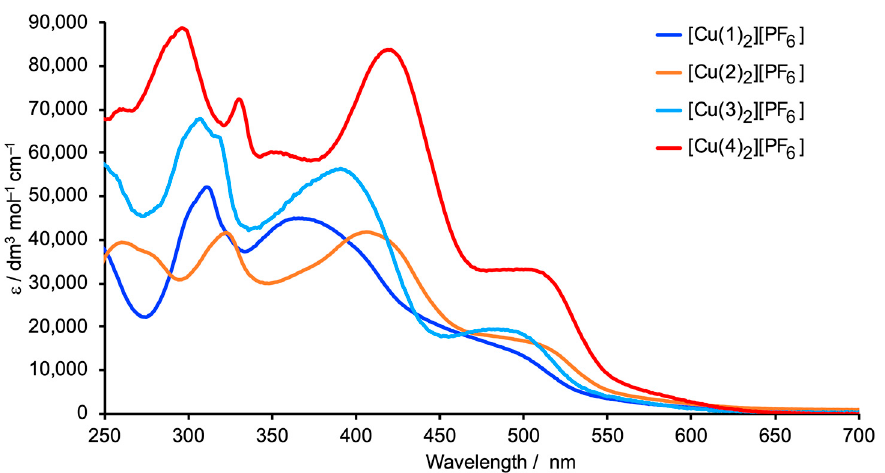
Figure 3. Solution absorption spectra of [CuL 2 ][PF 6 ] with L = 1 – 4 (CHCl 3 , 3.4 × 10 − 5 mol dm − 3 for L = 1 ,